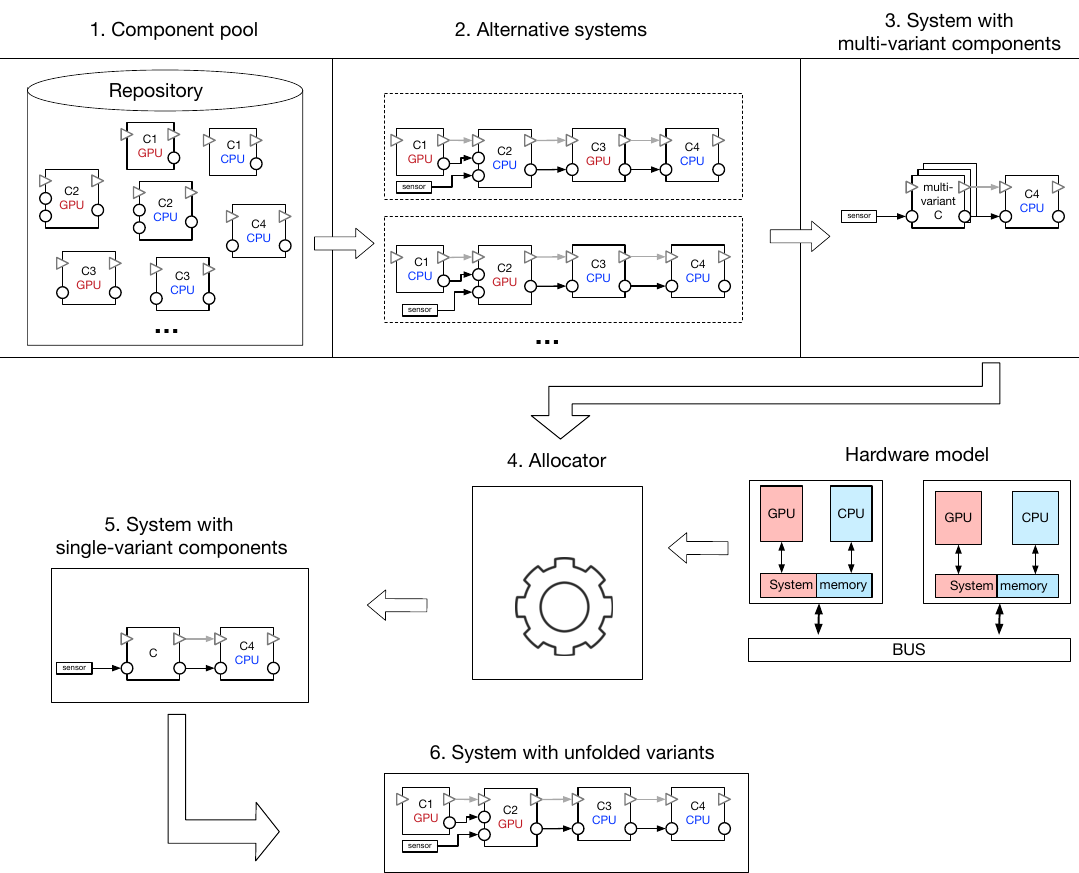
Figure 4. The overview description of our